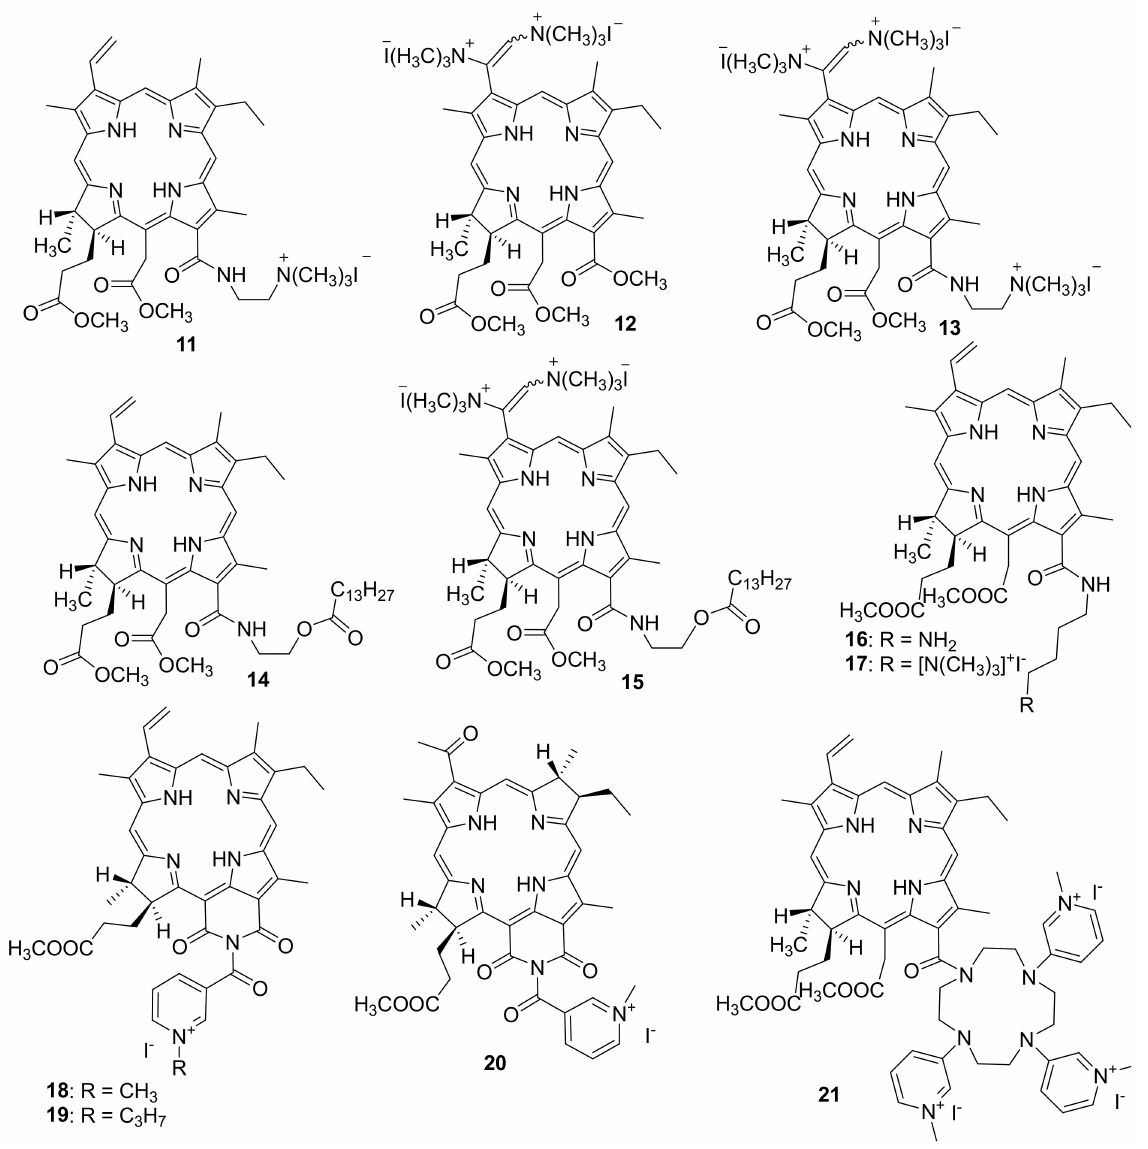
Figure 3. Cationic derivatives based on chlorins and heterocyclic